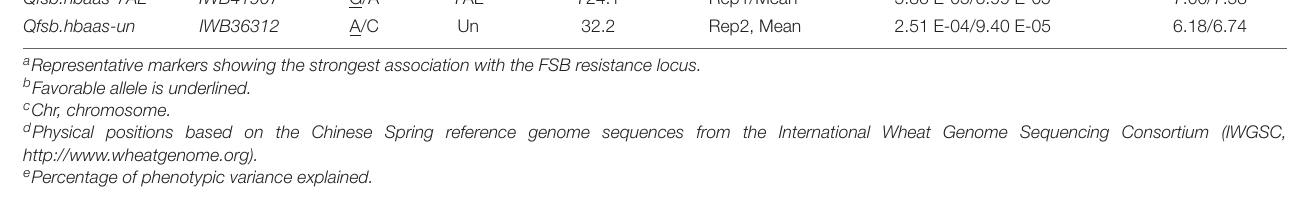
greater (31.7 and 36.3%, respectively). In Qfsb.hbaas-3AS , successfully used to develop KASP markers ( Table 5 ). All 240 wheat accessions were genotyped by these KASP markers. The results demonstrated that the genotypes from the KASP test were identical to the chip assay with low-frequency oscillations (2.5, 5.0, 3.3, and 3.8% for each marker, respectively).